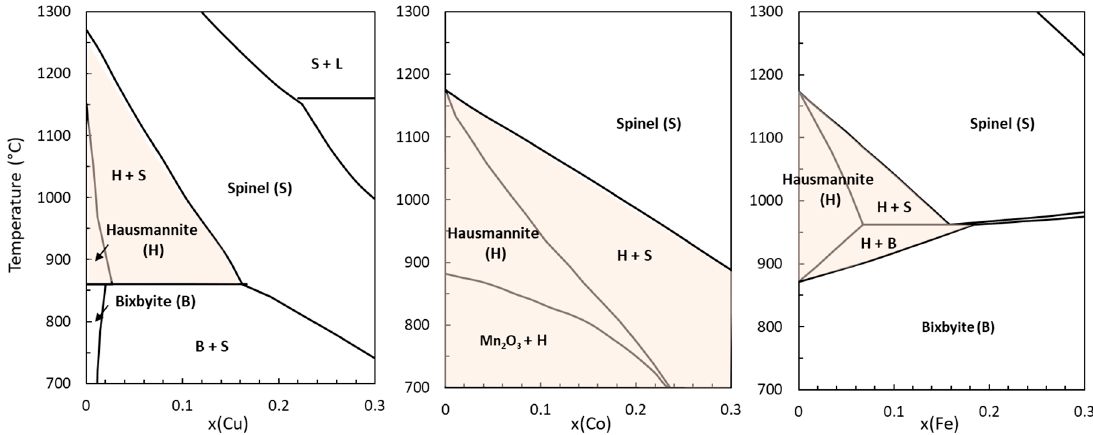
Figure 7. Mn-rich part of the Mn-Cu, Mn-Co and Mn-Fe phase diagrams in air (replotted from [49,51,57]).